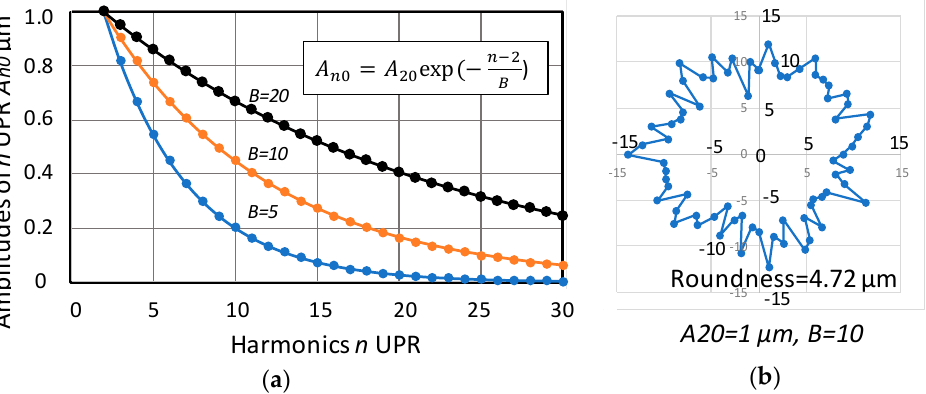
Figure 5. Initial amplitude distributions and roundness. ( a ) Initial amplitude distribution; ( b ) Initial roundness.